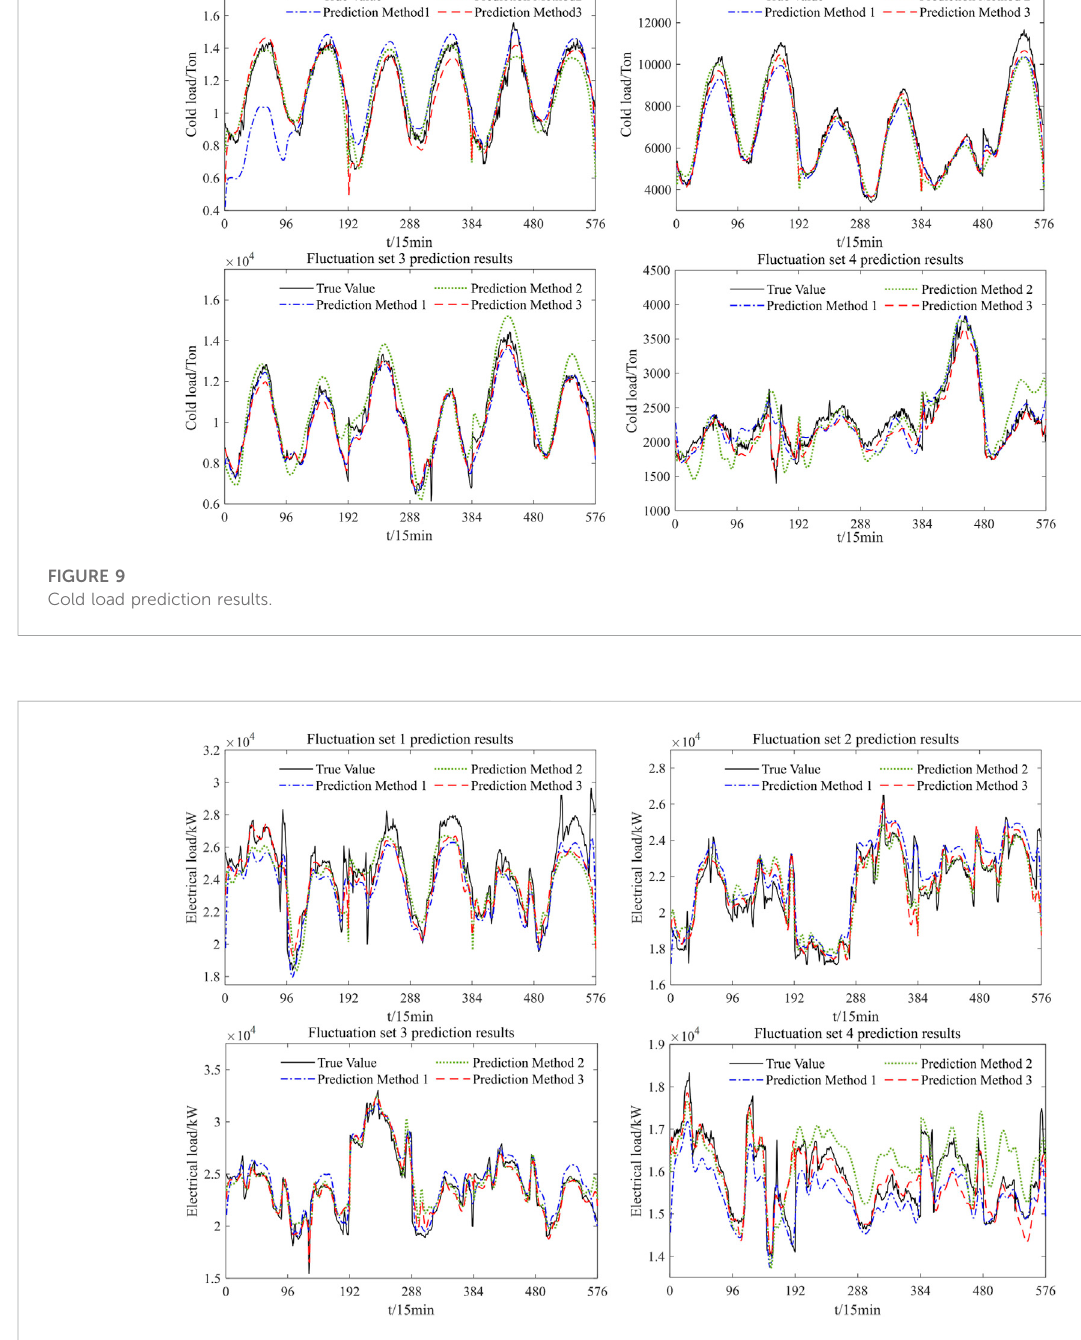
FIGURE 10 Electrical load prediction